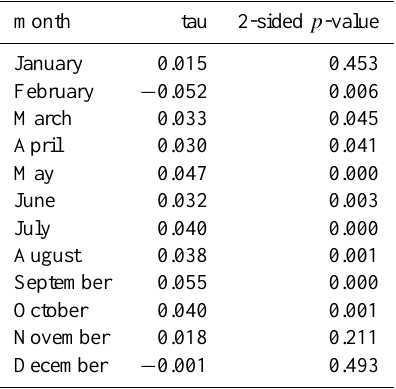
Table 2. Mann-Kendall trend test of R -factor using the monthly dataset of of all Swiss stations. Tau is the Mann-Kendall rank cor- relation coefficient.